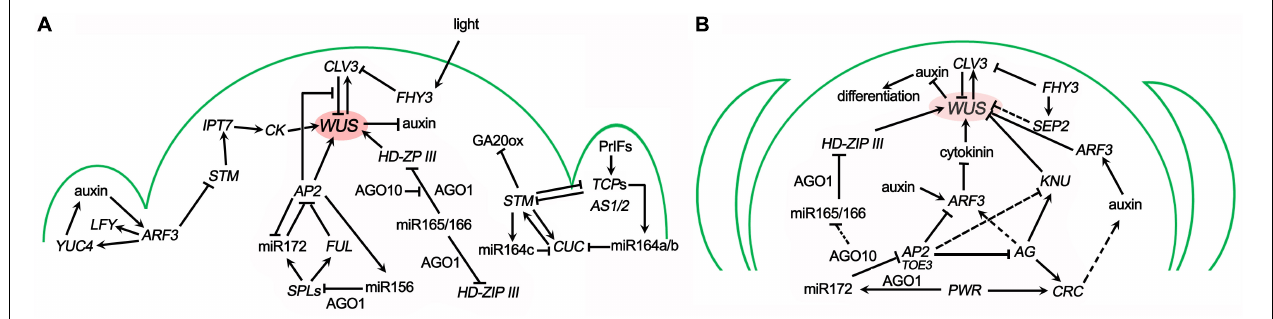
FIGURE 2 | Genetic pathways in the SAM maintenance (A) and FM determinacy (B) . The arrows represent the activation of gene expression, while the flat arrows represent its repression. The OC is shown in magenta. The genetic interactions are introduced in the text.